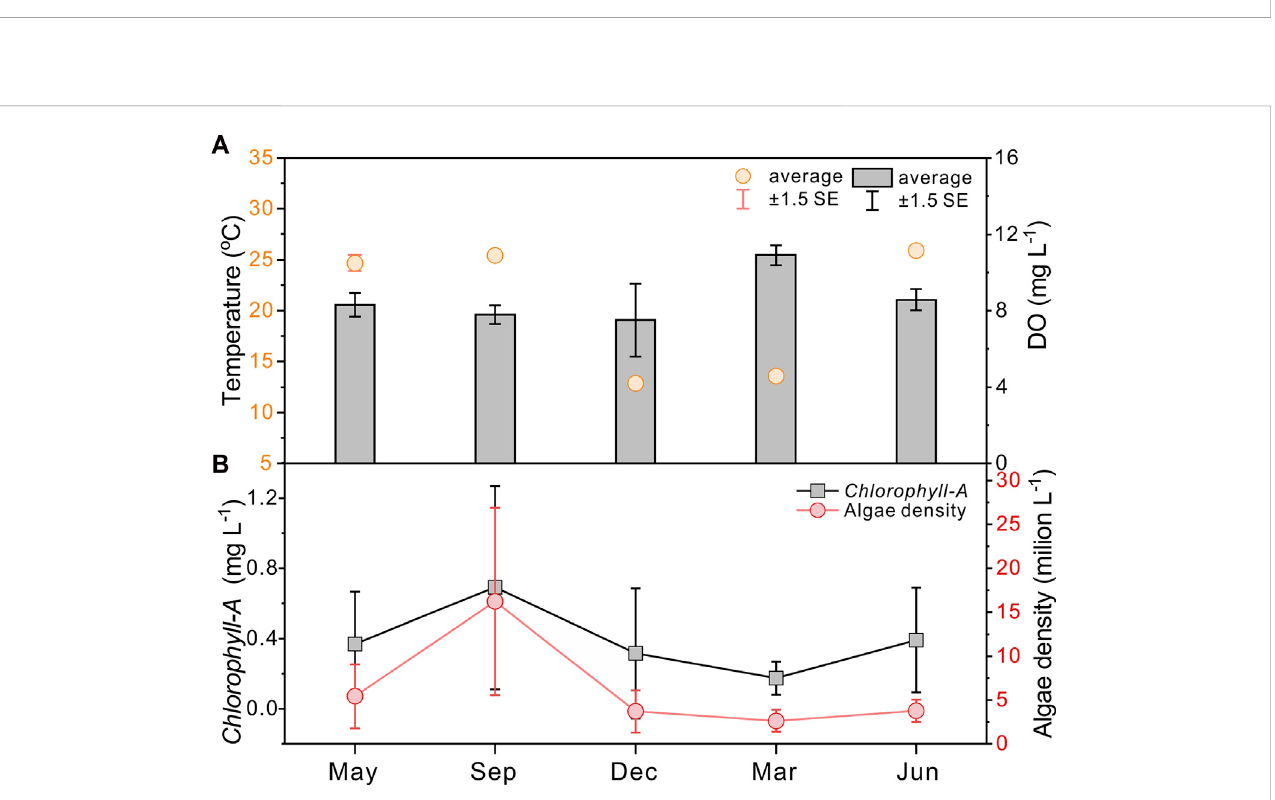
FIGURE 2 Seasonality of average temperature and dissolved oxygen (DO) in the water column (A) and Chlorophyll-A concentrations and algae densities (B) from Huang et al. (2019).